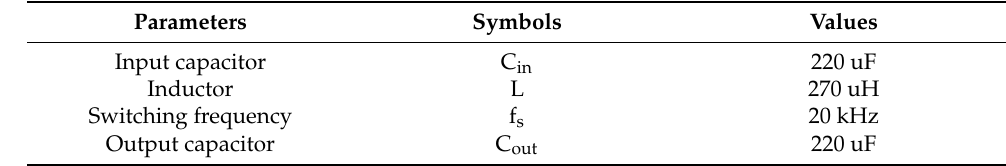
Figure 6. Simulation circuit of a standalone PV system with a boost converter. Table 1. Boost converter specifications.